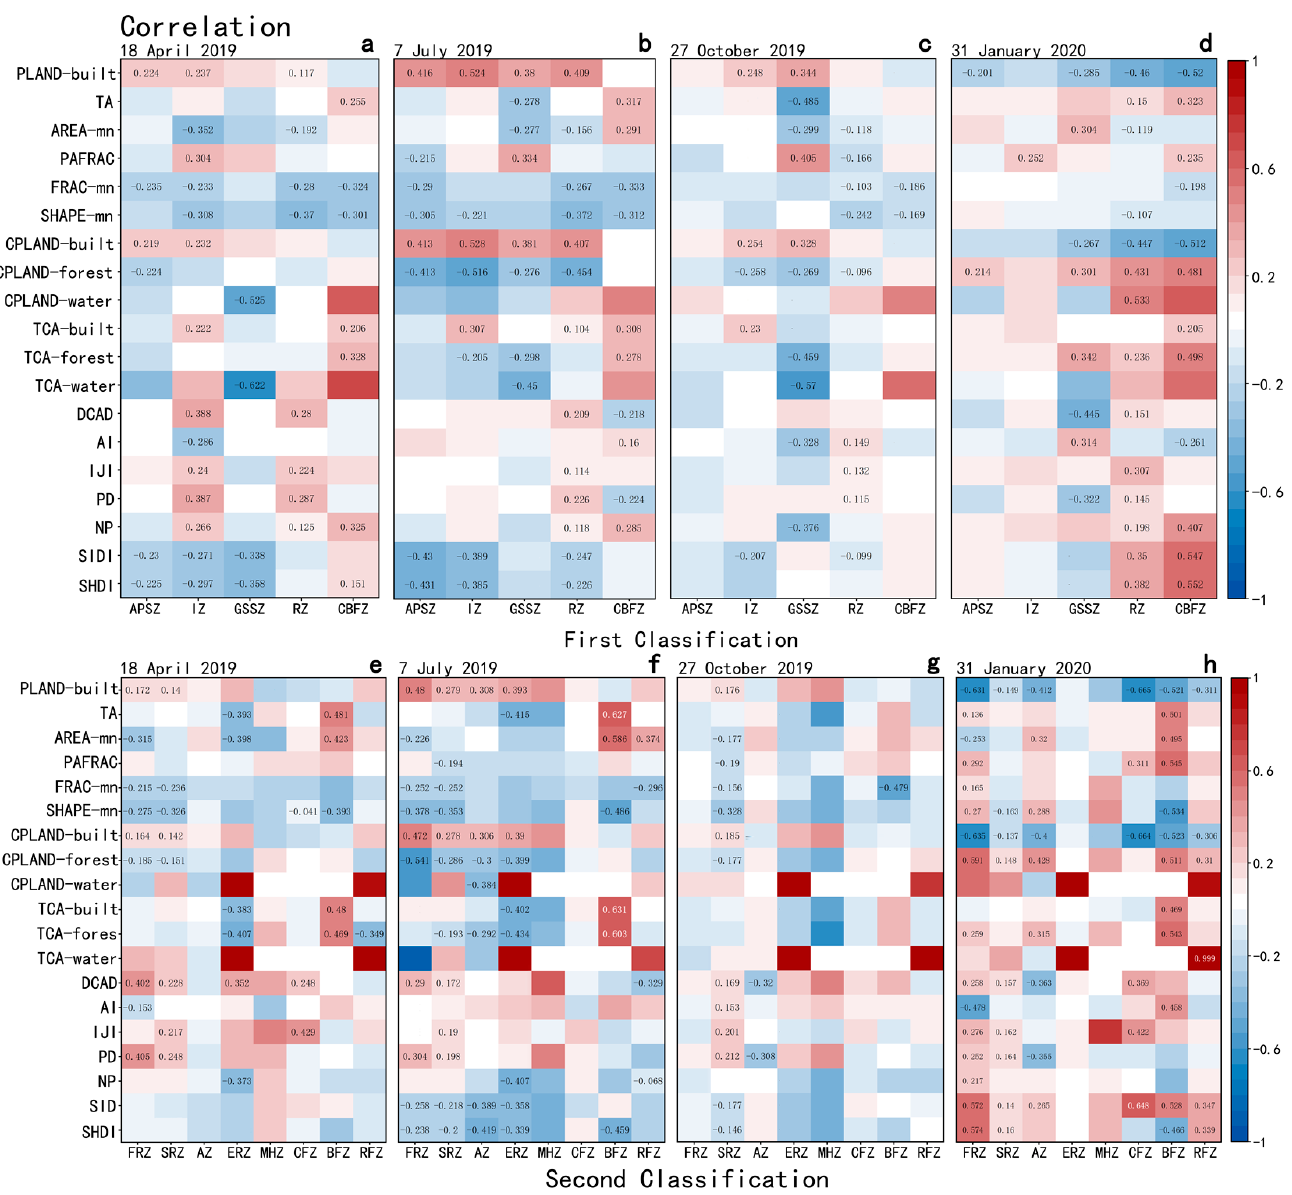
Figure 7. Pearson correlation. Pearson correlation coefficients shown in blank are statistically insignificant; others are significant. ( a – d ) Correlation analysis and statistics for the first category of land use classification and LST; ( e – h ) correlation analysis and statistics for the second category of land use classification and LST.